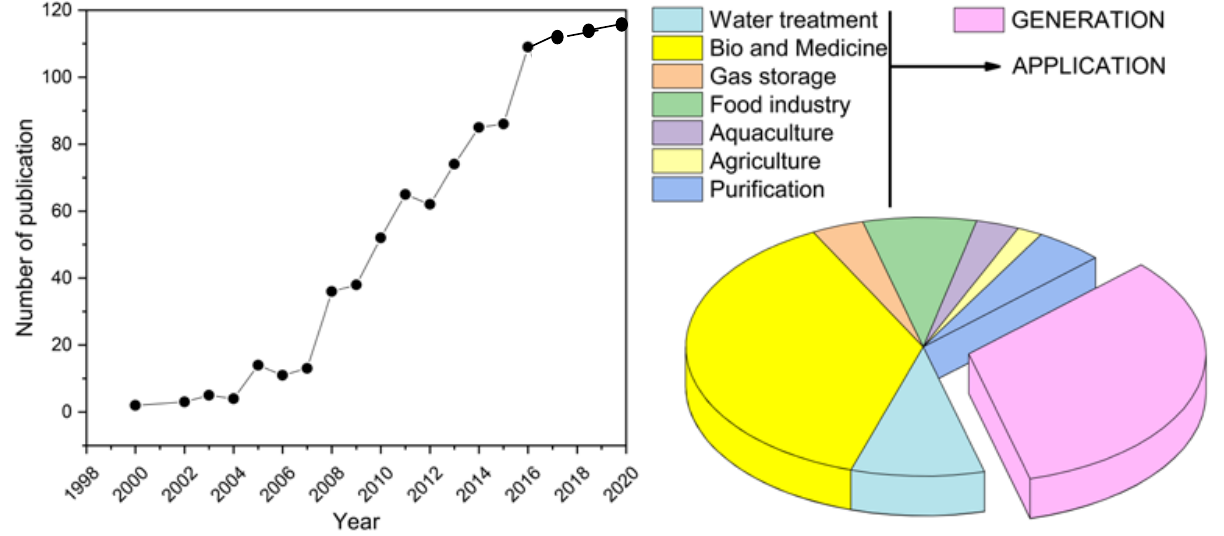
Figure 1. A 20-year literature search on nanobubble-related publications; various keywords listed above. Image credit: adapted from one supplied by M.R. Ghaani.